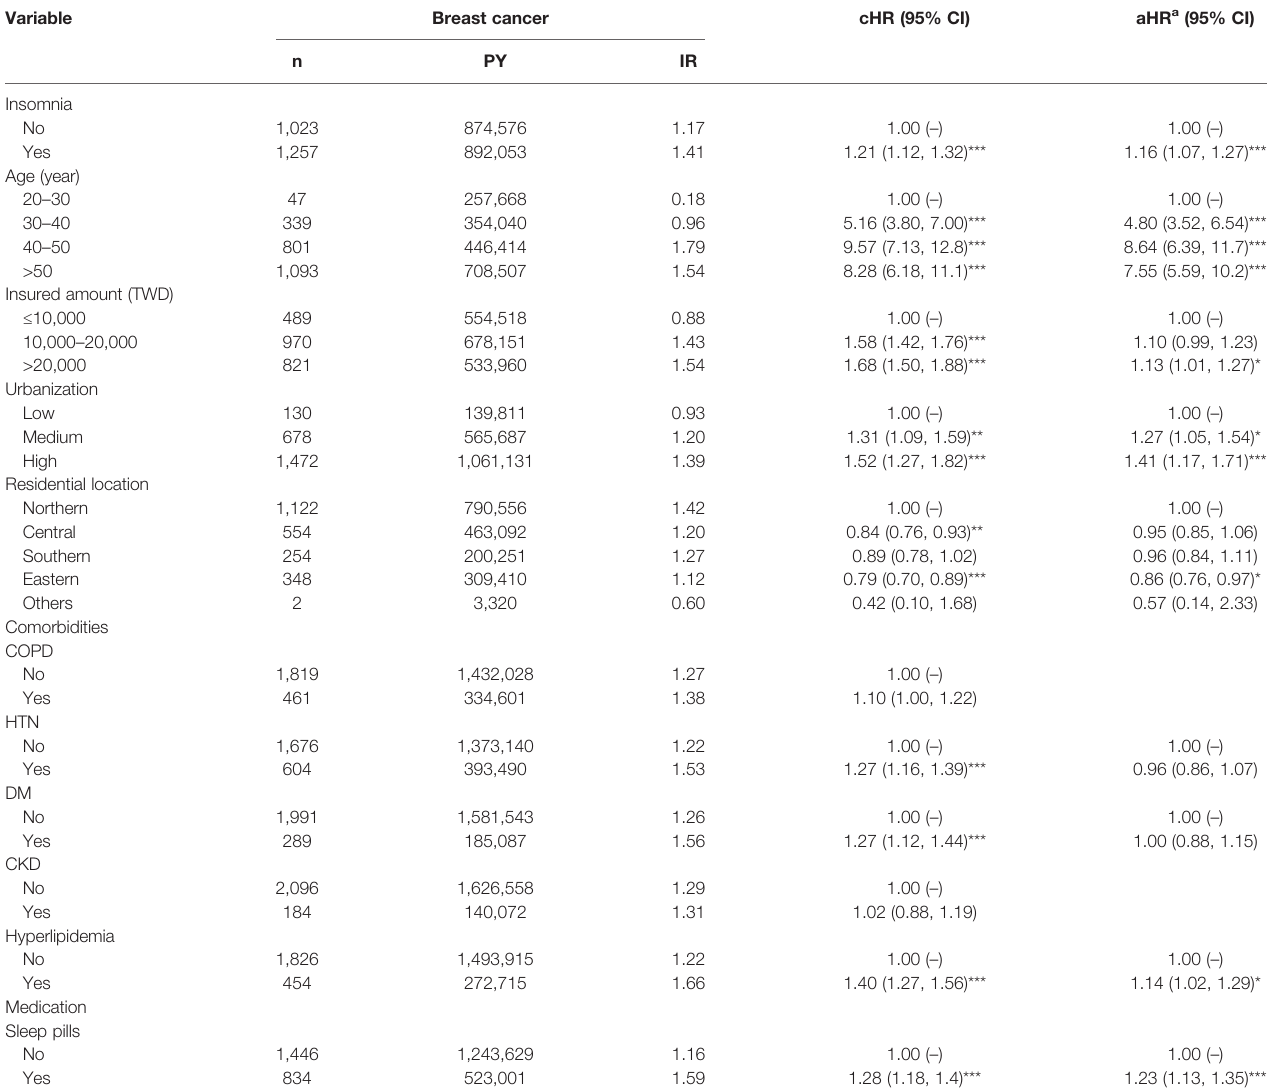
TABLE 4 | The incidence rates and hazard ratios of breast cancer in insomnia cohort. Variable Breast